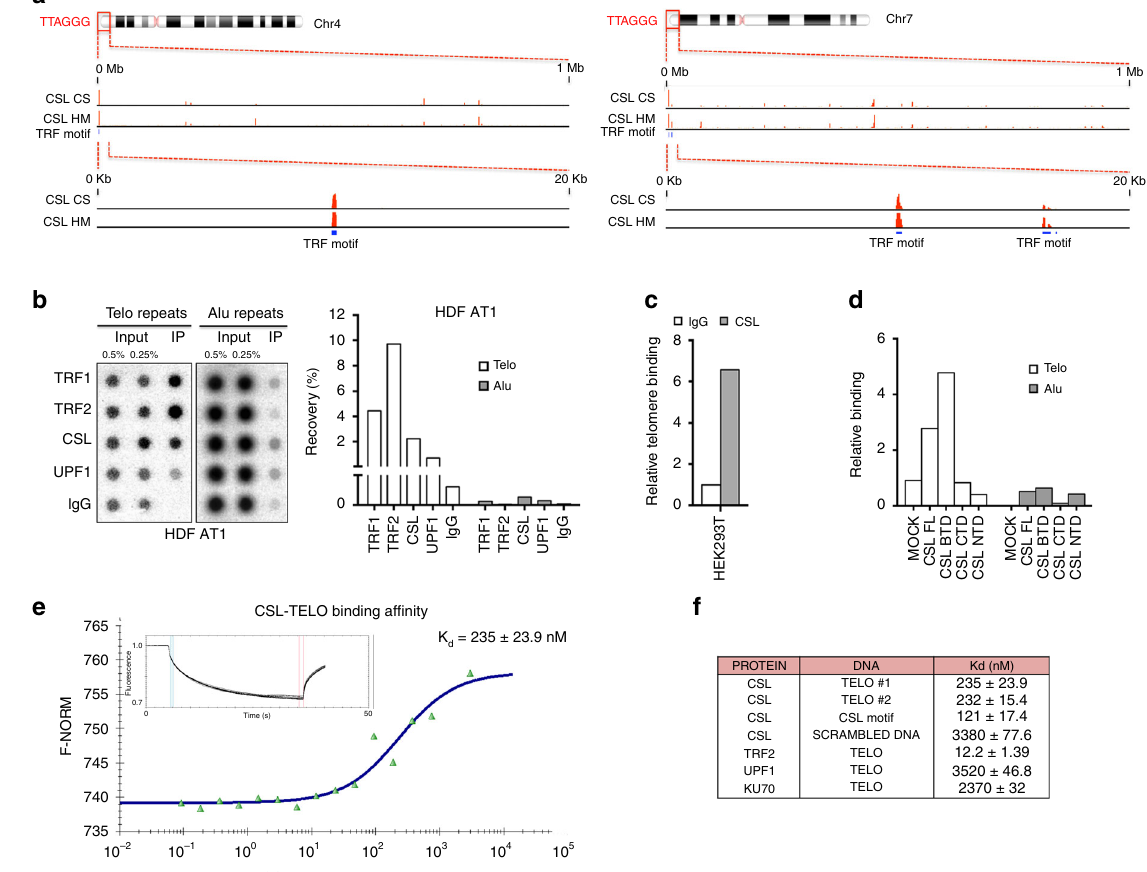
Fig. 6 CSL binds to telomeres. a Position of CSL binding peaks (red) at telomeric ends of two chromosomes (chr4 and chr7) as revealed by Chromatin IP combined with DNA sequencing (ChIP-seq) analysis with two different anti-CSL antibodies (CS, Cell Signaling; HM, HomeMade) 22 . Chromosomal regions of CSL binding are shown at two different scales together with the predicted position of TRF binding motifs (blue bars). Complete list and position of CSL binding sites at chromosome ends detected by ChIP-seq analysis in HDFs is provided in Supplementary Data 2. b Densitometric quanti fi cation of CSL binding to telomeres by ChIP assays of a HDF strain (AT1) with antibodies against the indicated proteins in parallel with non-immune IgG followed by DNA dot blot hybridization with probes detecting telomeric (Telo) or Alu repeats. Similar experiments with two other HDF strains (AT2 and AT3) are in Supplementary Fig. 7a. c Telomere binding assay by ChIP/qPCR with antibodies against endogenous CSL, in parallel with non-immune IgG, in HEK293T cells. d Telomere binding assays of HEK293T cells expressing FLAG-tagged CSL full length (FL), CSL BTD, CSL CTD, or CSL NTD domains by ChIP/qPCR with anti-FLAG antibodies followed by qPCR with telomere- and alu-speci fi c primers. Non-immune IgGs were used for normalization. A second independent experiment is shown in Supplementary Fig. 7b. e Binding of recombinant CSL protein to telomeric repeat DNA (TELO) as measured by MST. Inset: thermophoretic movement of fl uorescently-labeled TELO. A second independent experiment and speci fi city controls are shown in Supplementary Fig. 7c – f. f Summary table of dissociation constants ( K d ) of the indicated proteins from TELO DNA as determined by MST assays. SCRAMBLED DNA was used as speci fi city